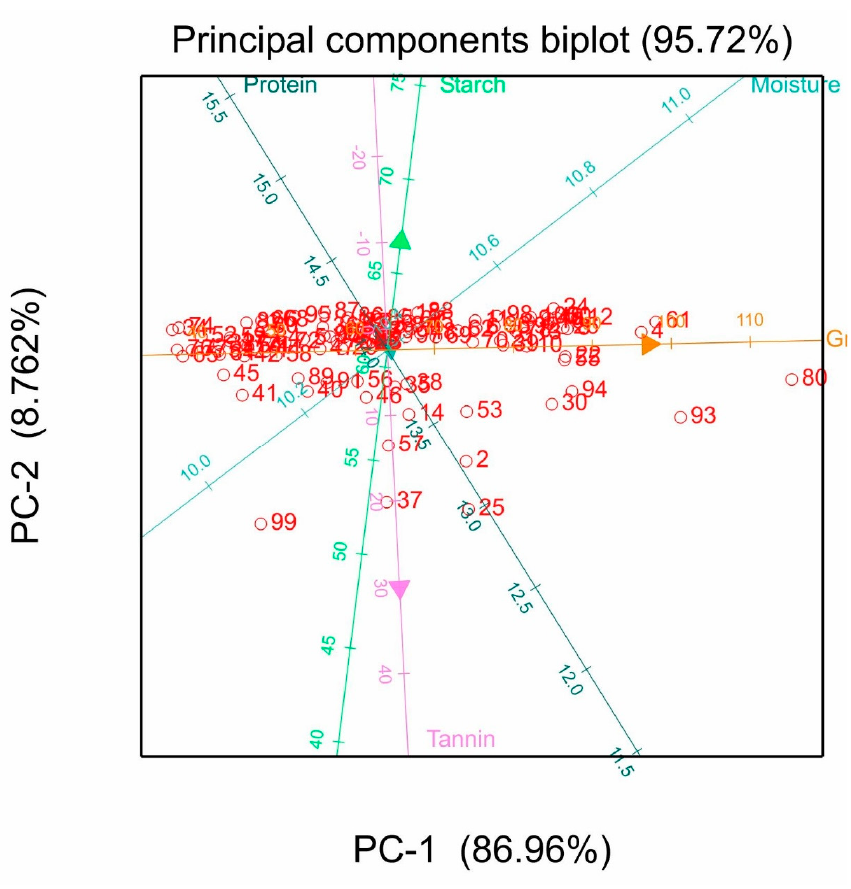
Figure 2. The principal component analysis biplot showing positioning of sorghum accessions and factor analysis on the first and second principal components based on biochemical traits.